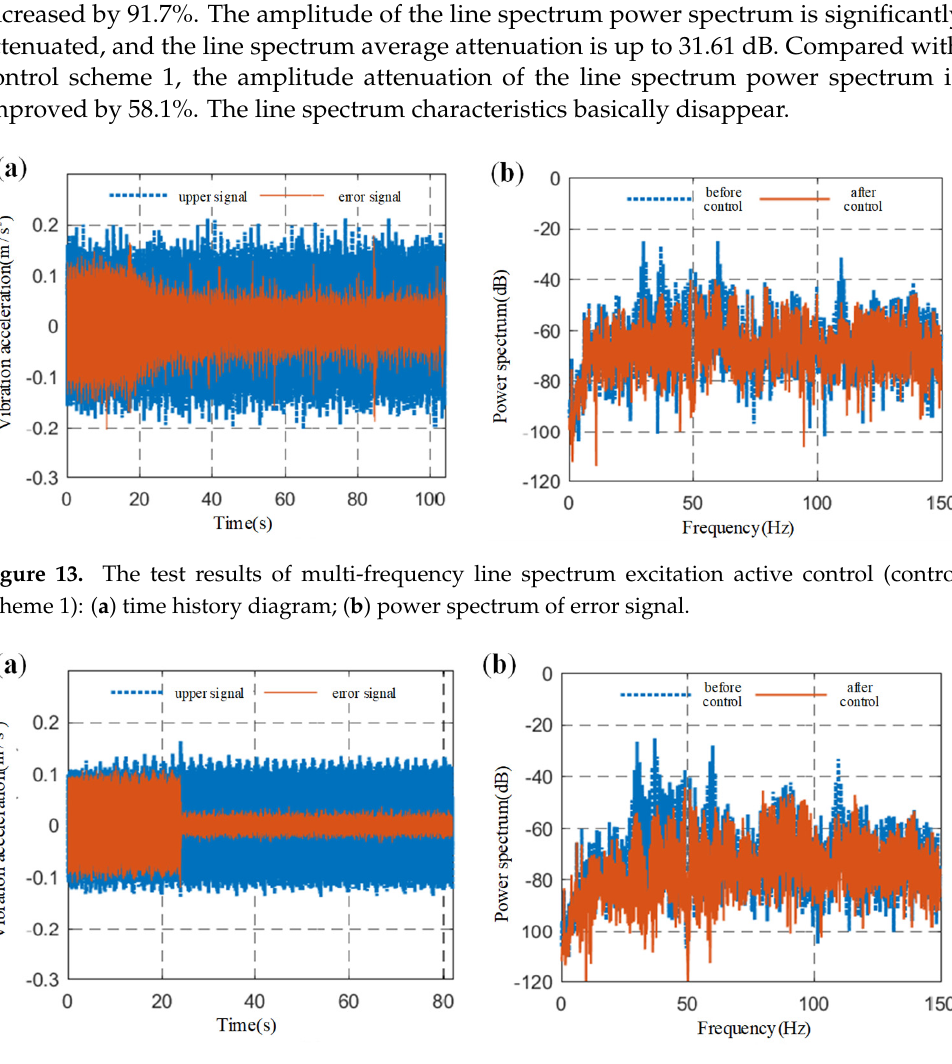
Figure 14. The test results of multi ‐ frequency line spectrum excitation active control (control scheme 2): ( a ) time history diagram; ( b ) power spectrum of error signal.